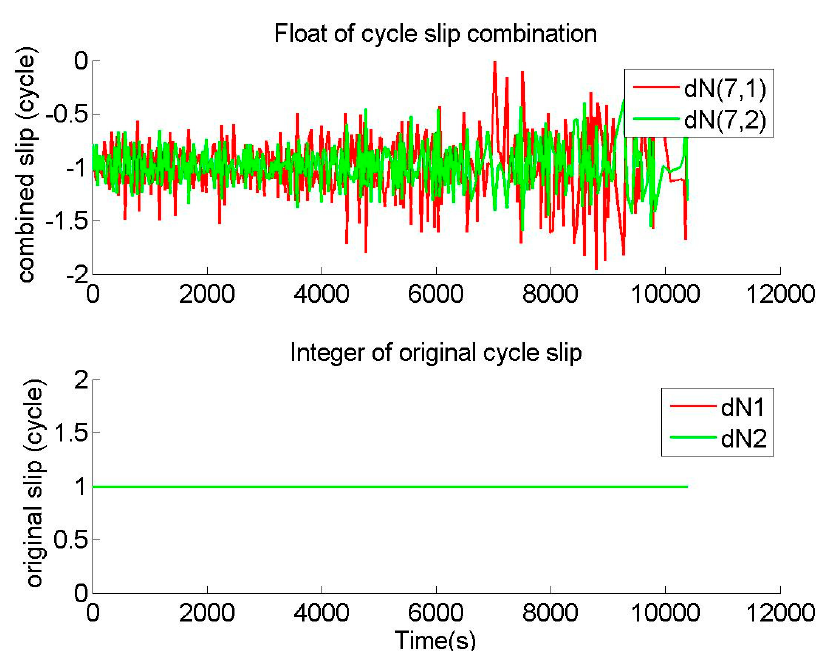
Figure 16. Results of the cycle-slip combinations and original cycle slip supplied by the BDCSR methodology from MEO Satellite 11 in a weak condition of low elevations during the geomagnetic storm, where the known cycle slips of (1,1) were inserted epoch-by-epoch in the phase data collected at the CUT0 station started from UTC 8 May 2016 00:00:00 with an interval of 30 s.